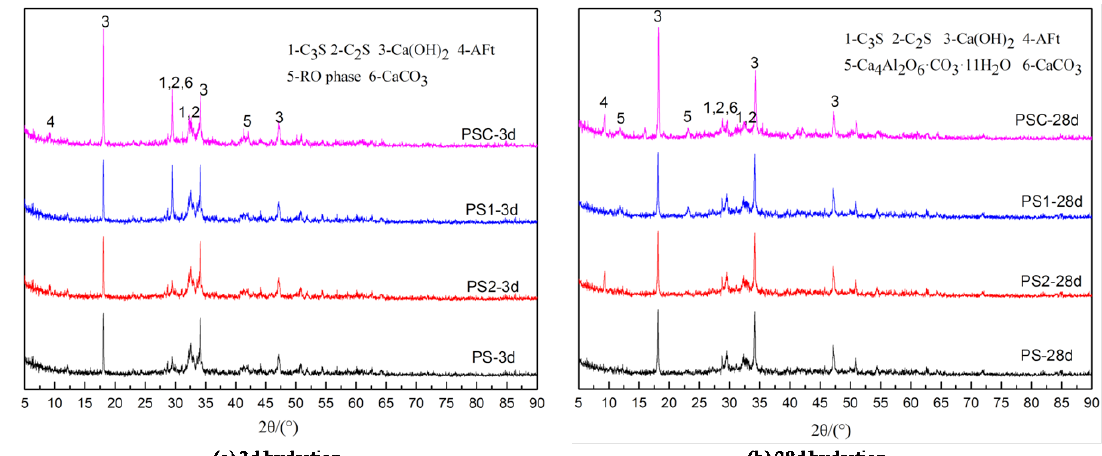
Fig. 5. XRD spectra of PS and PSC hydrated for 3 and 28days(a and b, respectively).